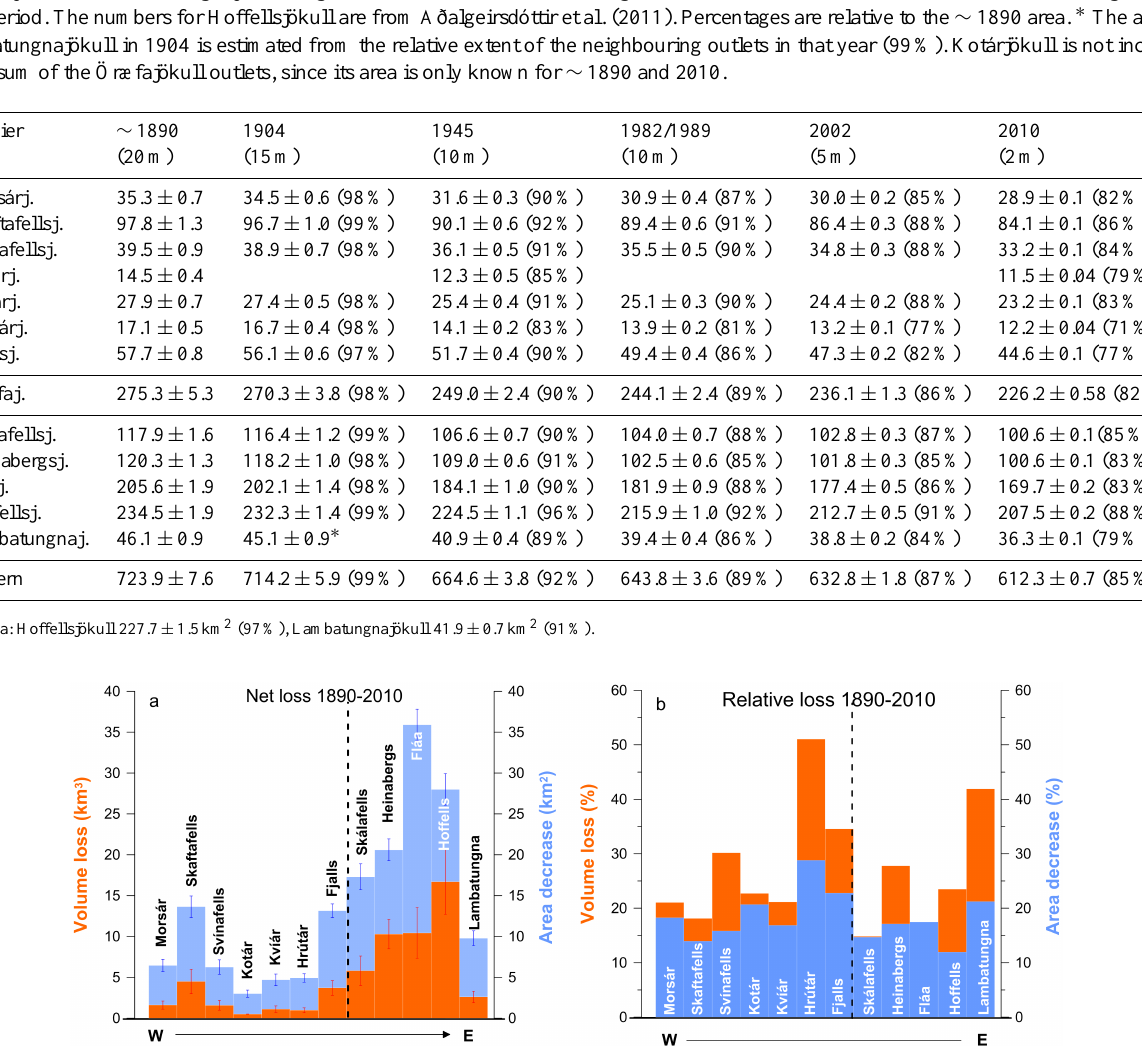
Figure 8. Total area decrease (light blue) and volume loss (orange) during the time period ∼ 1890–2010 (a) absolute values, and (b) relative to the LIA maximum size. Glaciers represented in geographical order and the dotted line separates the outlets of Öræfajökull and the eastern